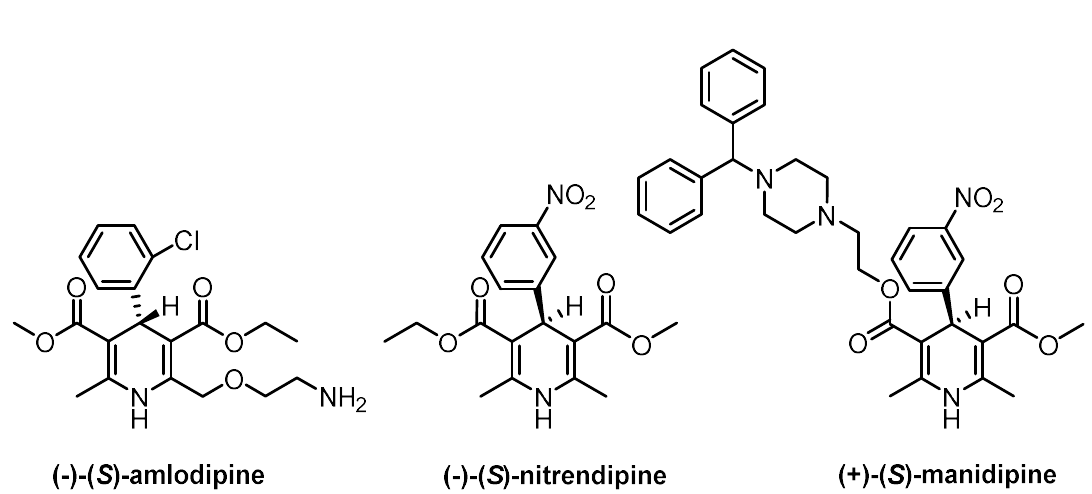
Figure 2. Structures of (−)-(S)-amlodipine, (−)-(S)-nitrendipine and (+)-(S)-manidipine.